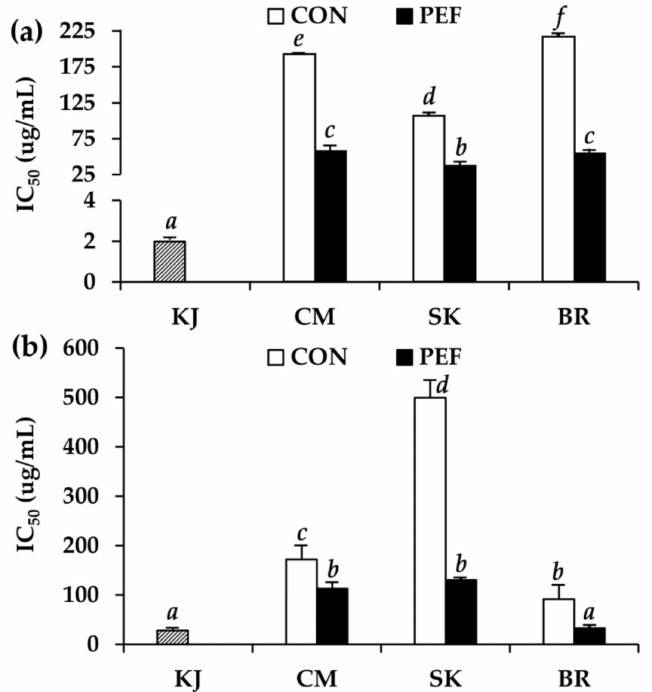
Figure 5. IC 50 against tyrosinase with substrates ( a ) l -tyrosine and ( b ) l -DOPA of kojic acid (KJ) M. alba leaf extract from Chiang Mai (CM), Sakon Nakhon (SK), and Buriram (BR). a , b , c , d , e , f denote significant di ff erences among samples in each experiment, P <